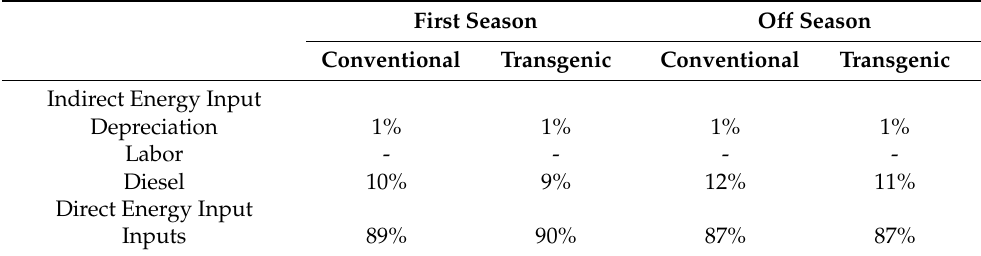
Table 4. Share of energy inputs for conventional and transgenic first and second season